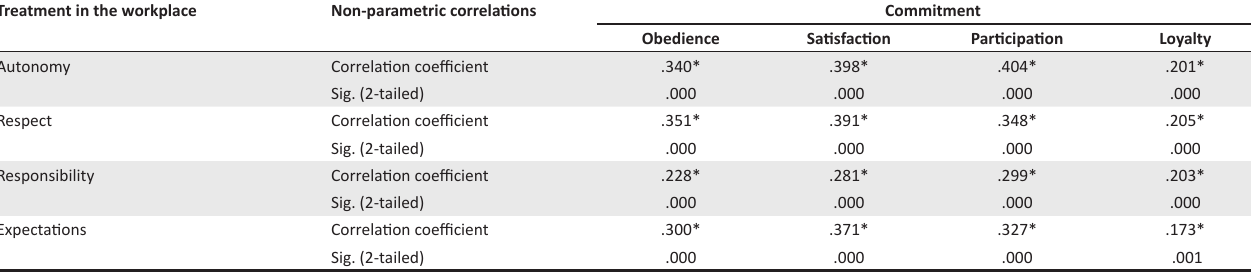
TABLE 4: Correlations between perceptions of fair treatment in the workplace and commitment. Treatment in the workplace Non-parametric correlations